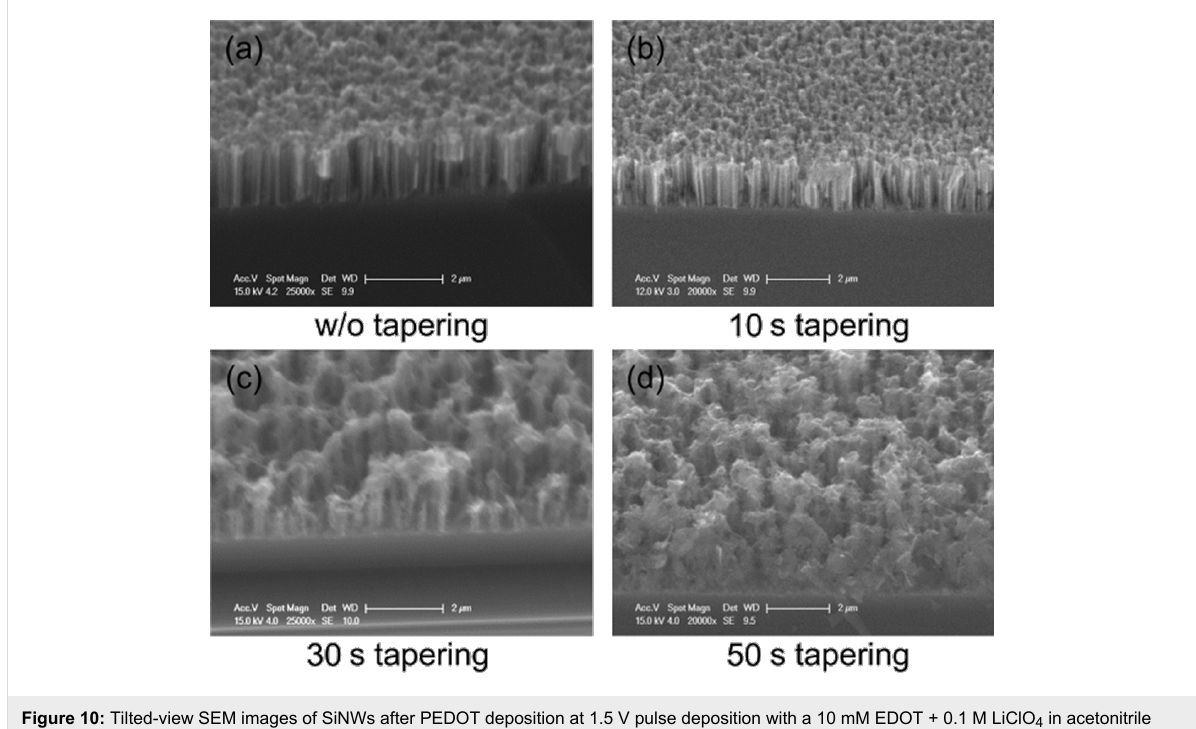
Figure 10: Tilted-view SEM images of SiNWs after PEDOT deposition at 1.5 V pulse deposition with a 10 mM EDOT + 0.1 M LiClO 4 in acetonitrile solution (a) without tapering, (b) after 10 s tapering, (c) after 30 s tapering and (d) after 50 s tapering.